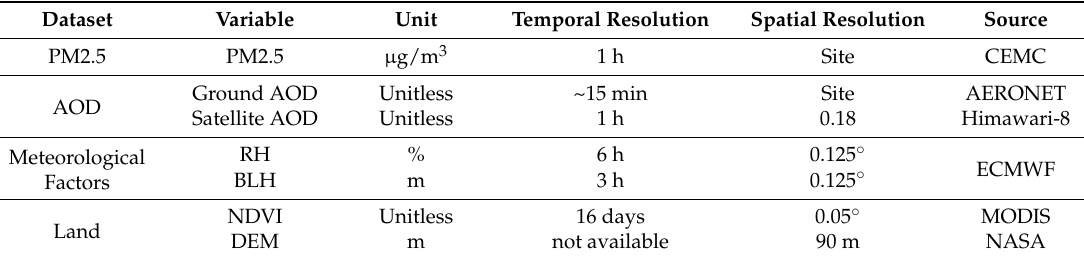
Table 1. Summary of datasets applied in this